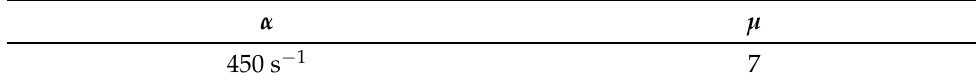
Table 2. Controller